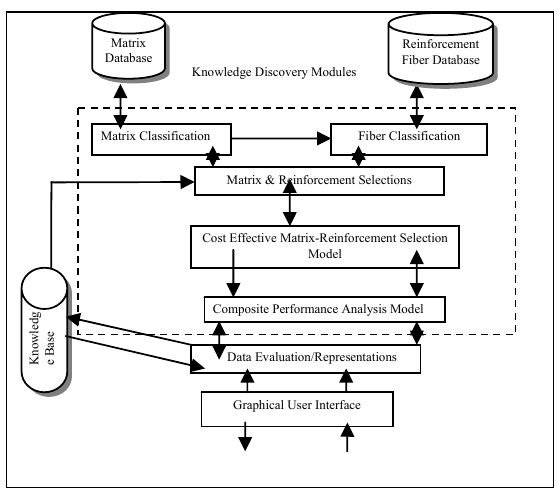
Figure 1: Data Mining Systems Architecture